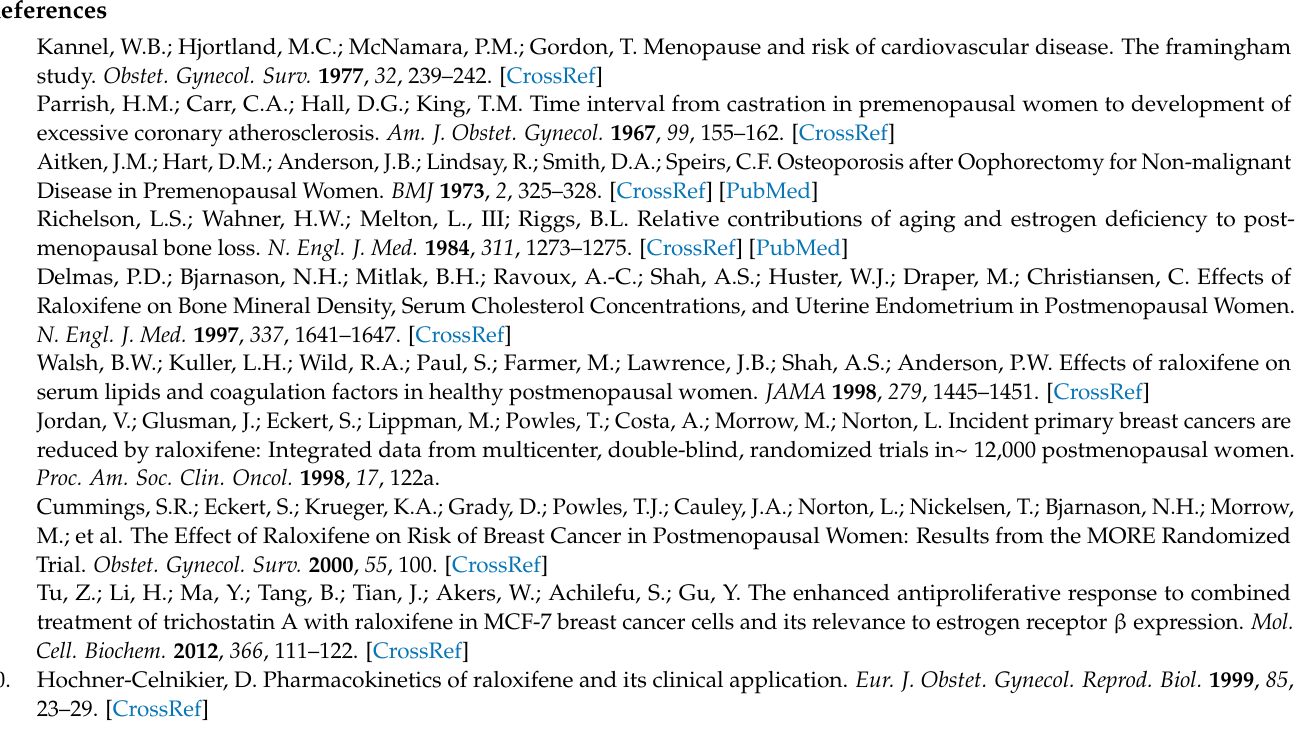
Figure S2: A photo of nanofibers film E2, Table S1: Non-parametric test summary, Table S2: Related- samples Wilcoxon signed rank test summary, Table S3: Between-subjects factors, Table S4: Multivari- ate tests, Table S5: Tests of between-subjects